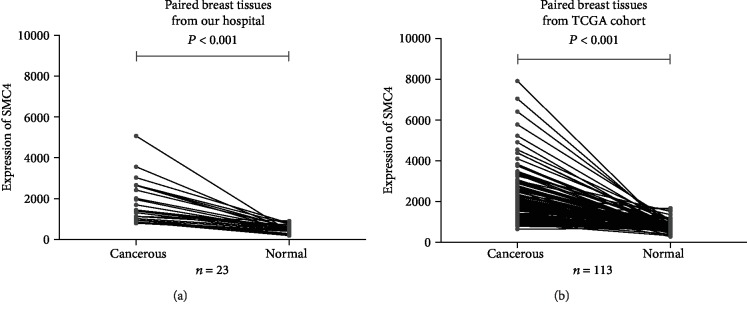
The mRNA expression levels of SMC4 upgraded in cancerous tissues, both in the 23 paired human specimens (a) (P < 0.001) and in the TCGA dataset (b) (P < 0.001).